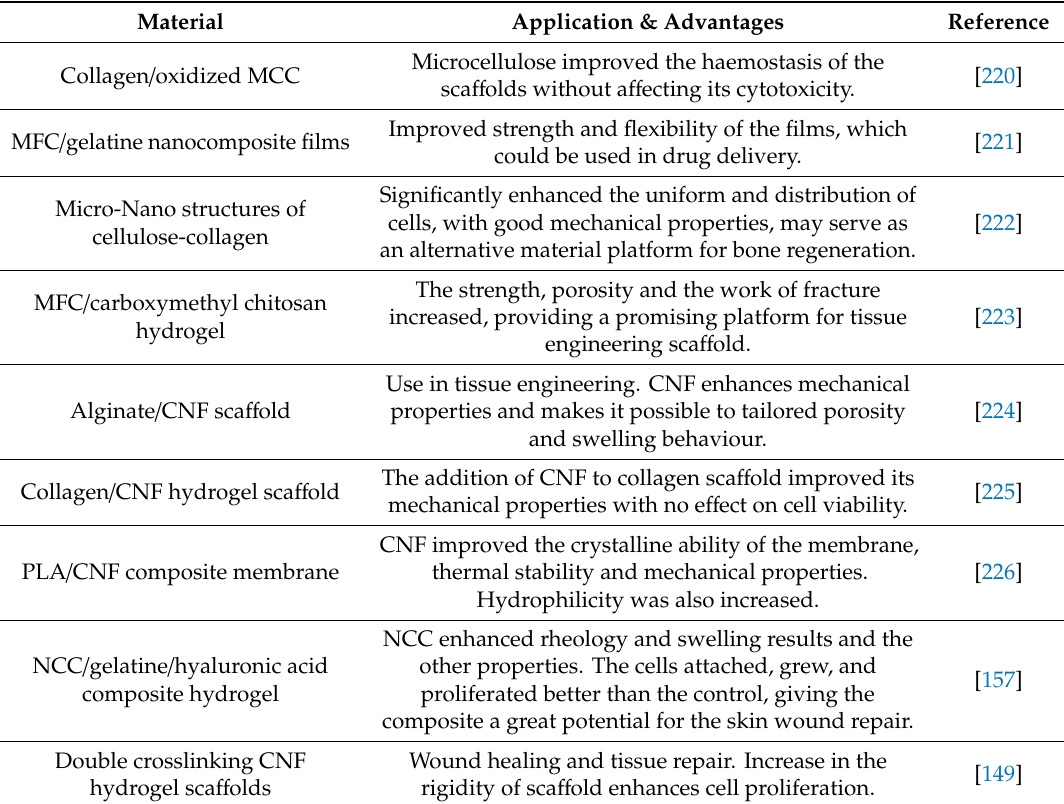
Table 9. Summary of selected applications of micro- and nanocellulose-based sca ff olds.